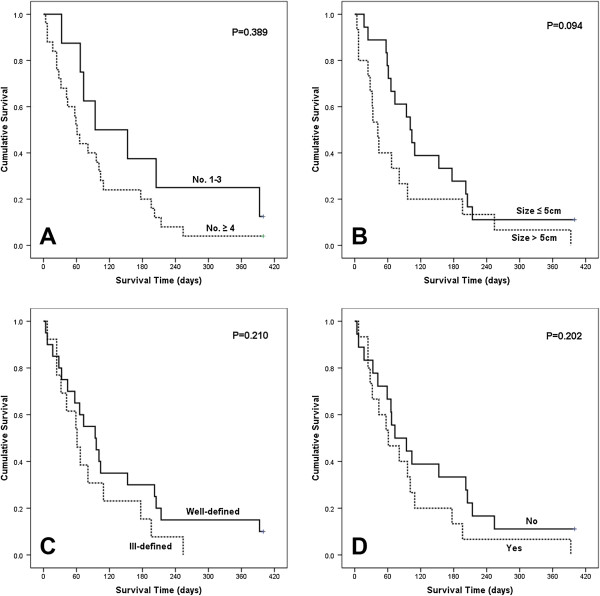
Kaplan-Meier analyses of overall survival for 33 patients according to HCC characteristics. (overall comparison was estimated using a log-rank test). A: Number of nodule, B: Size of the largest nodule, C: Type of HCC, D: Presence of portal vein thrombosis.